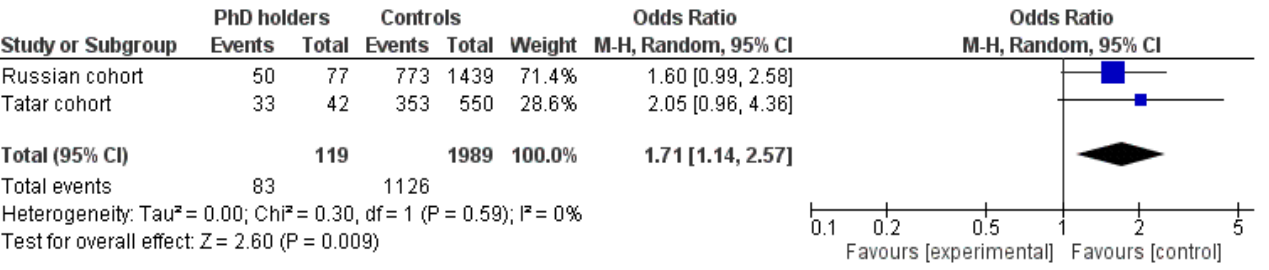
Figure 3. Meta-analysis for association studies for the KIBRA gene and PhD status. The prevalence of the rs17070145 CT/TT genotypes has been shown in PhD holders. The purple squares represent the ratio of CT/TT genotypes in PhD holders for each individual study. The black diamond represents the pooled ratio of CT/TT genotypes in all PhD holders and its 95% CI.